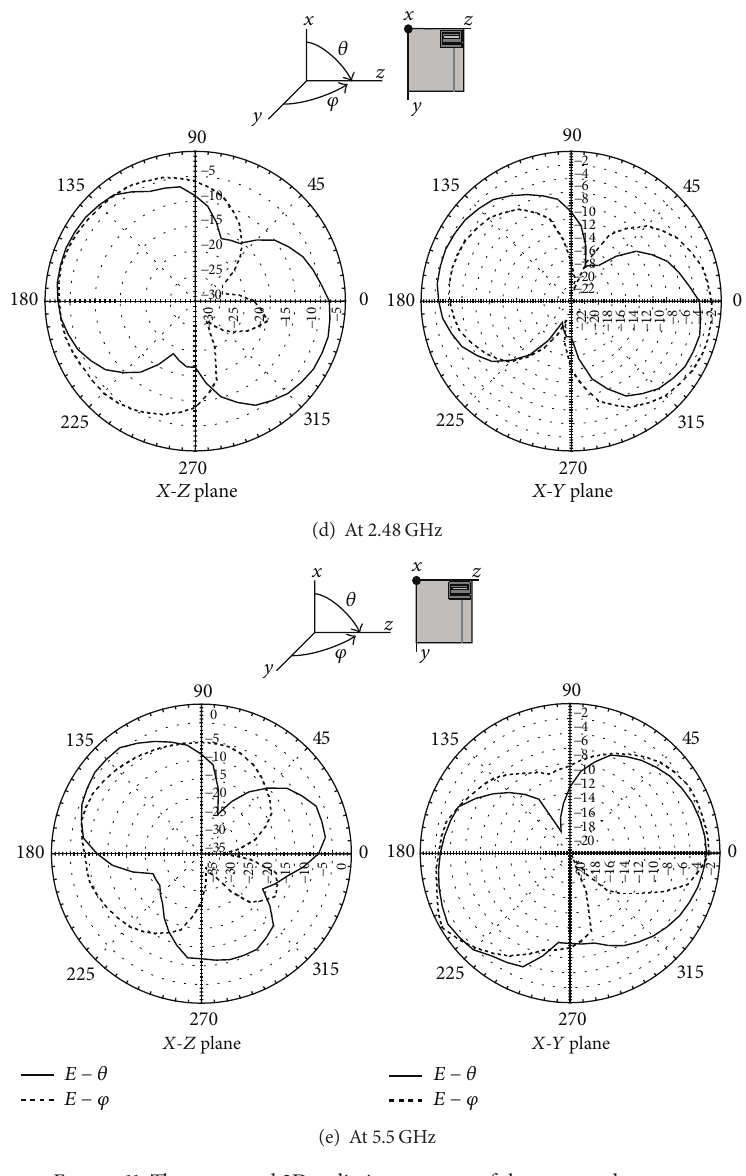
Figure 11: The measured 2D radiation patterns of the proposed